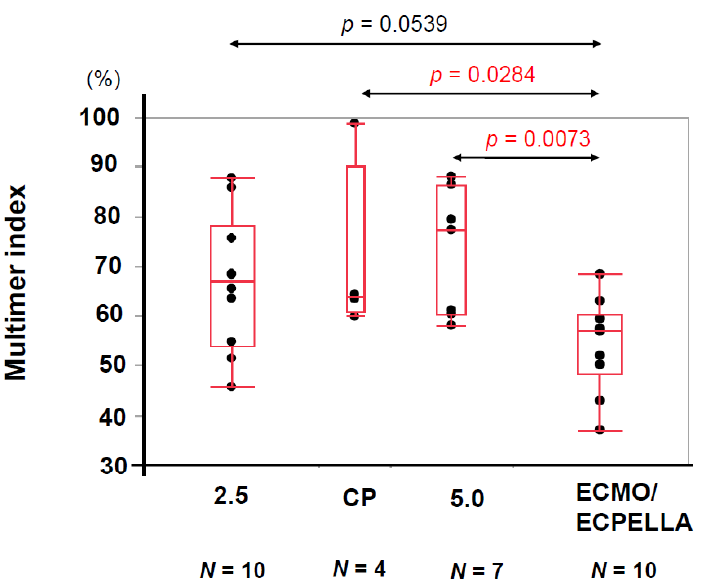
Figure 5. Comparison of vWF large-multimer index in each device were shown. The median values of vWF large-multimer index of Impella 2.5, Impella CP, Impella 5.0, and ECMO/ECPELLA were 66.9, 63.9, 77.3, and 57.1, respectively. The differences of vWF large-multimer index between Impella CP and ECMO/ECPELLA, and Impella 5.0 and ECMO/ECPELLA were 0.0284 and 0.0073 by Wilcoxon rank sum test. vWF, von Willebrand factor; ECMO, extracorporeal membrane oxygenation; ECPELLA, extracorporeal membrane oxygenation, and Impella.